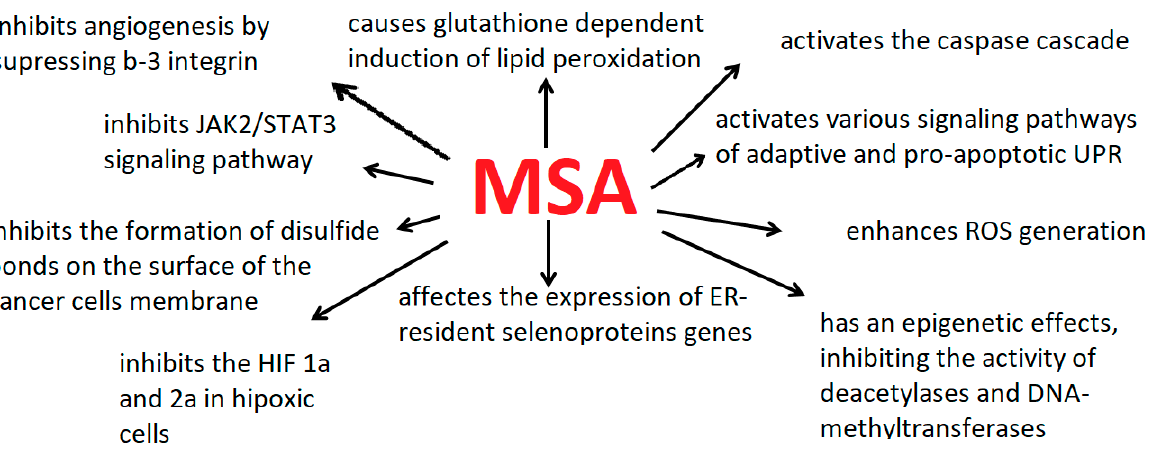
Figure 3. The main effects of MSA on cancer cells. Table 1. The main molecular mechanisms of regulations of MSA cytotoxicity on the example of various cancer cell lines. Cancer Cell Line